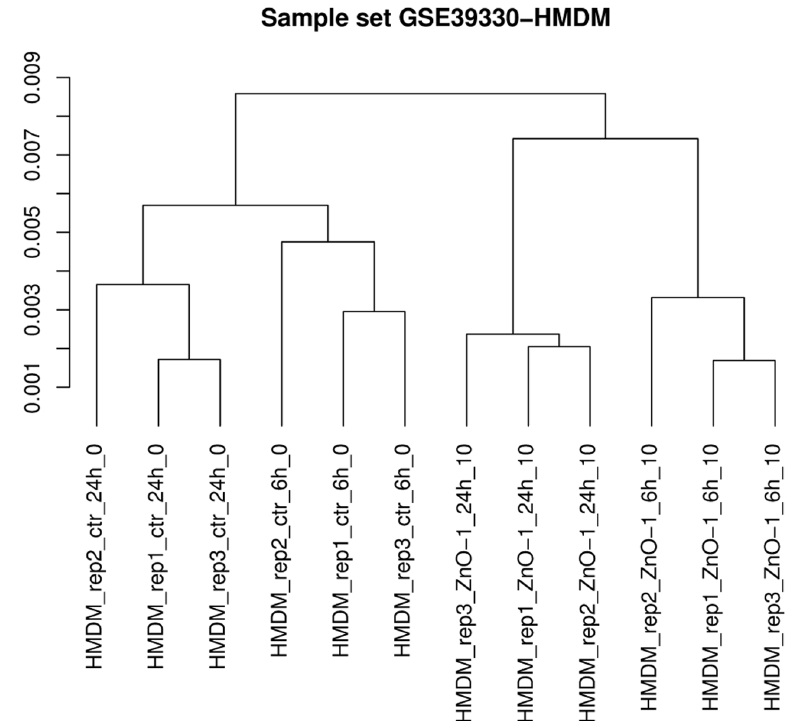
Figure 2. Example of clustering analysis in NanoMiner. The figure shows the clustering of the human monocyte-derived macrophages (HMDM) exposed to 10 m g/ml of ZnO nanoparticles for 6 or 24 hours or left as controls in dataset GSE39330. The clustering was performed using all data (12 samples and 17,617 genes) with Pearson correlation distance and average linkage.